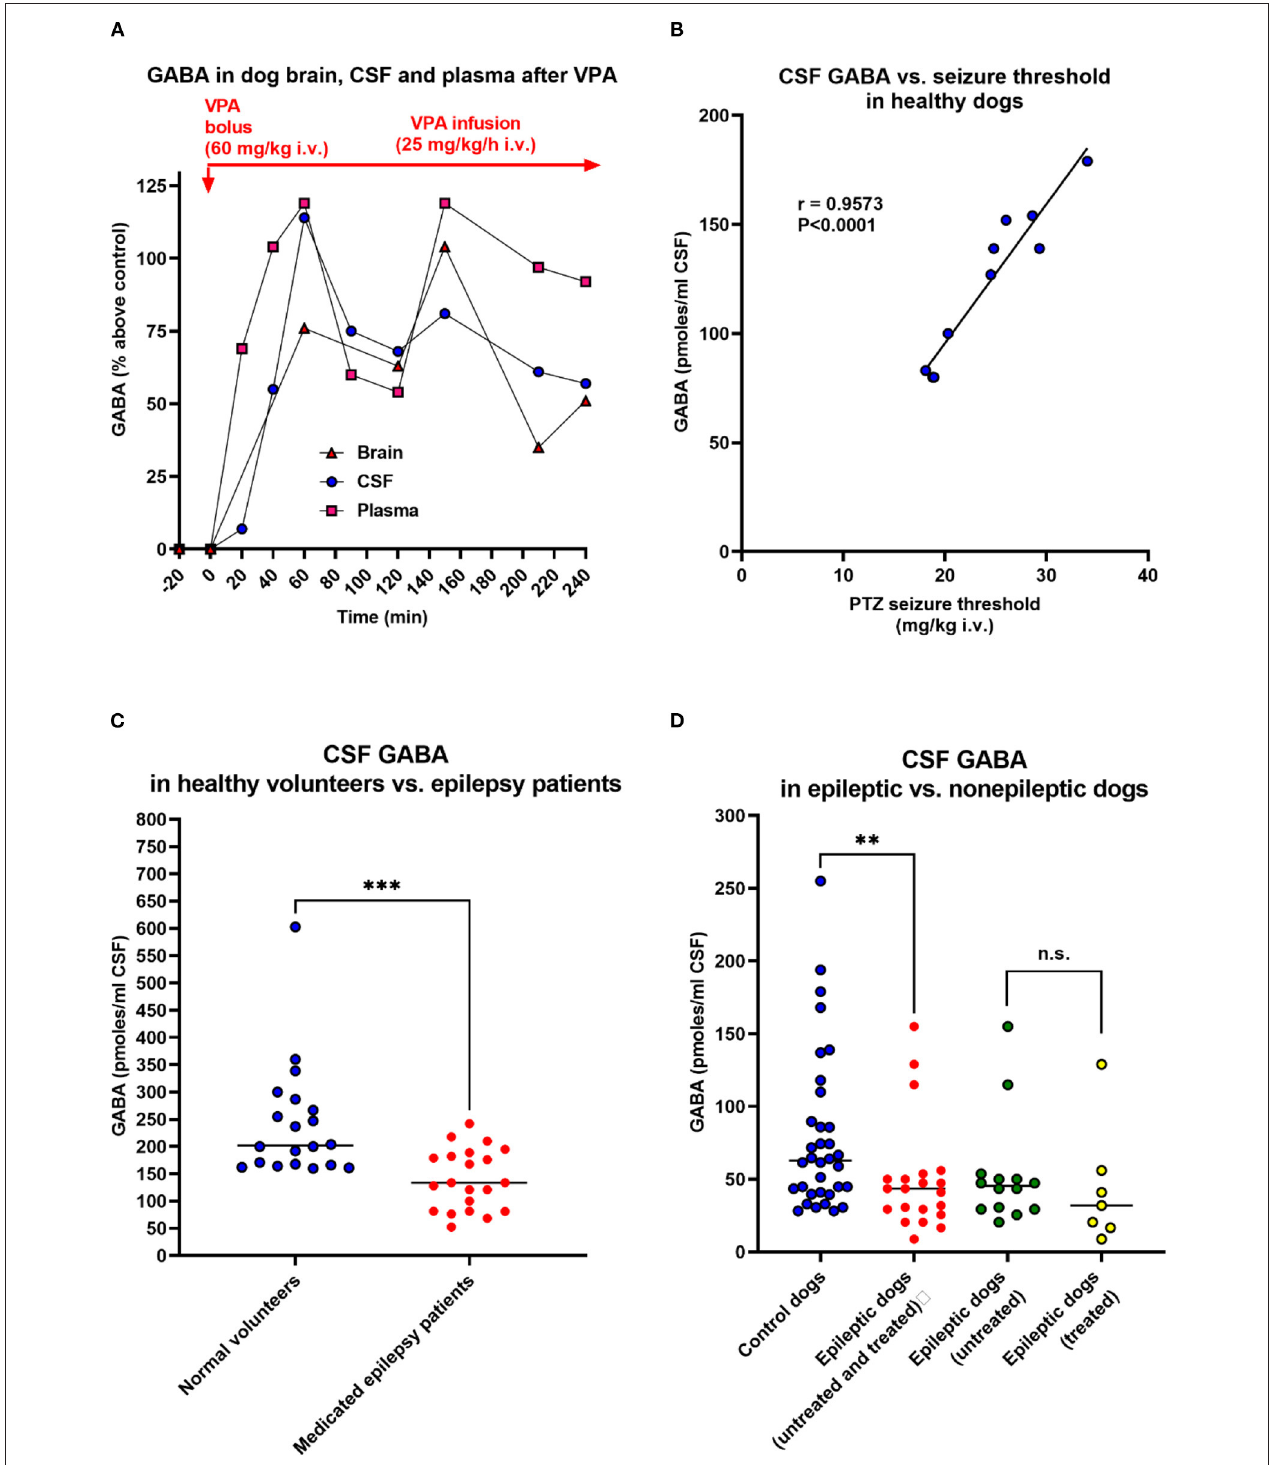
FIGURE 3 | Relationship between CSF GABA concentrations and neuronal excitability. In the dog studies shown in (A,B,D) , CSF was withdrawn from the subarachnoidal space by a suboccipital puncture during anesthesia. (A) GABA levels in the cerebral cortex, CSF, and plasma during the administration of the antiseizure drug valproate (VPA) in an anesthetized dog. Similar experiments were performed with vigabatrin and other GABA-T inhibitors to investigate the relationship between GABA levels in the brain parenchyma and those in CSF and plasma. Unexpectedly, these experiments showed that plasma GABA alterations